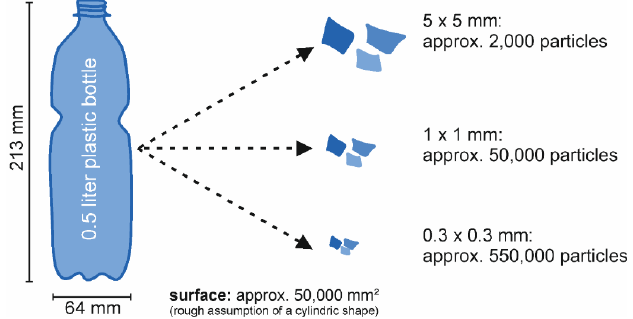
Figure 7. Rough estimation of the surface of a 0.5 L plastic bottle and the resulting amount of microplastic particles.